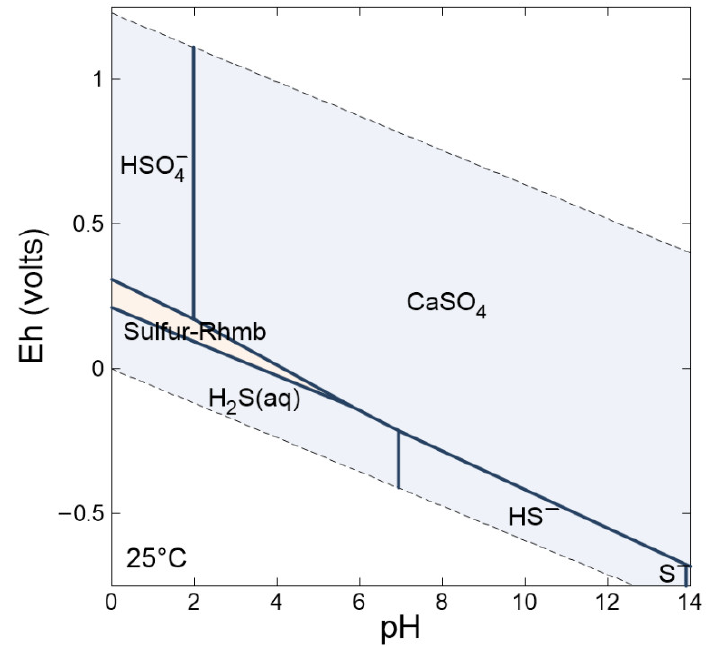
Figure A31. Low sulfur 150 mg/L, Ca 5 mM (200 mg/L), bicarbonate 7 mM (427 mg/L), sulfate 4 mM (384 mg/L), and chloride 2 mM (71 mg/L).